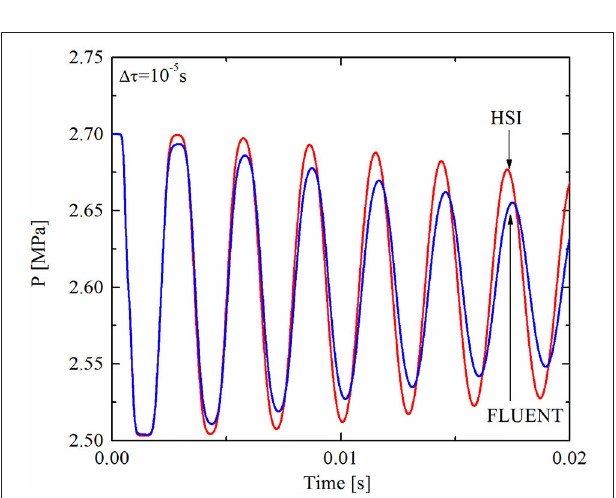
FIGURE 8 | Comparisons between the HSI method and the exact solution.